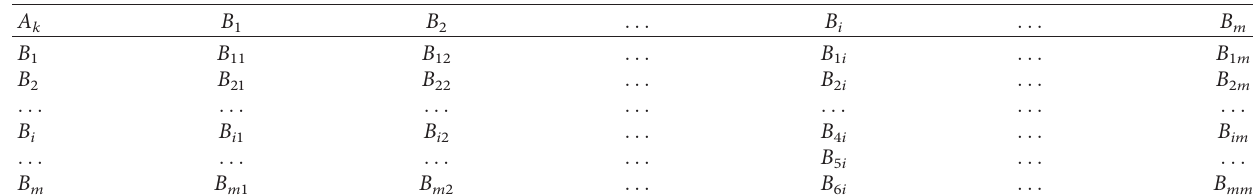
Table 4: Judgment